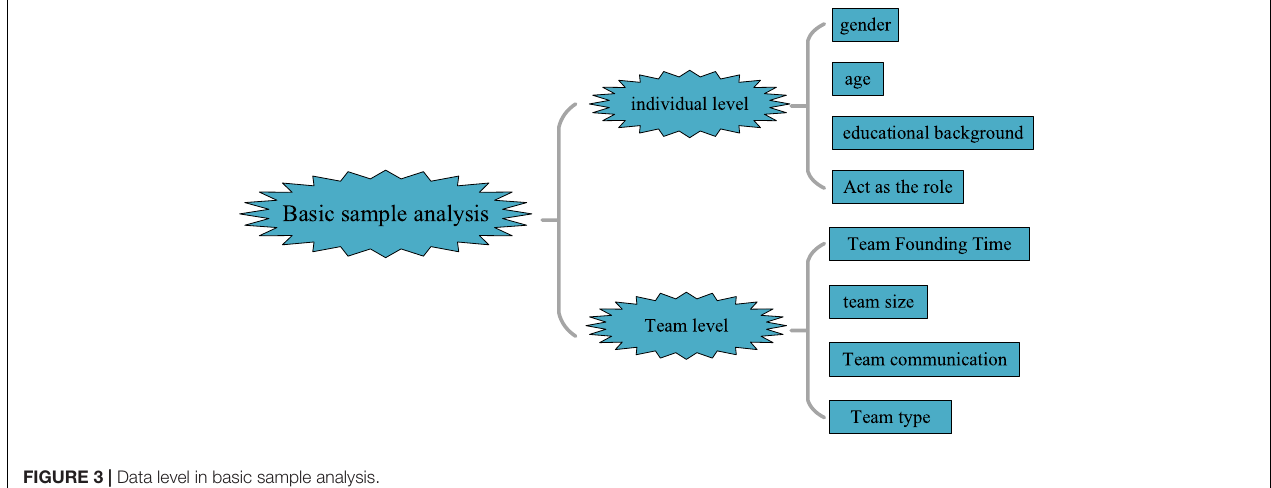
FIGURE 3 | Data level in basic sample analysis.